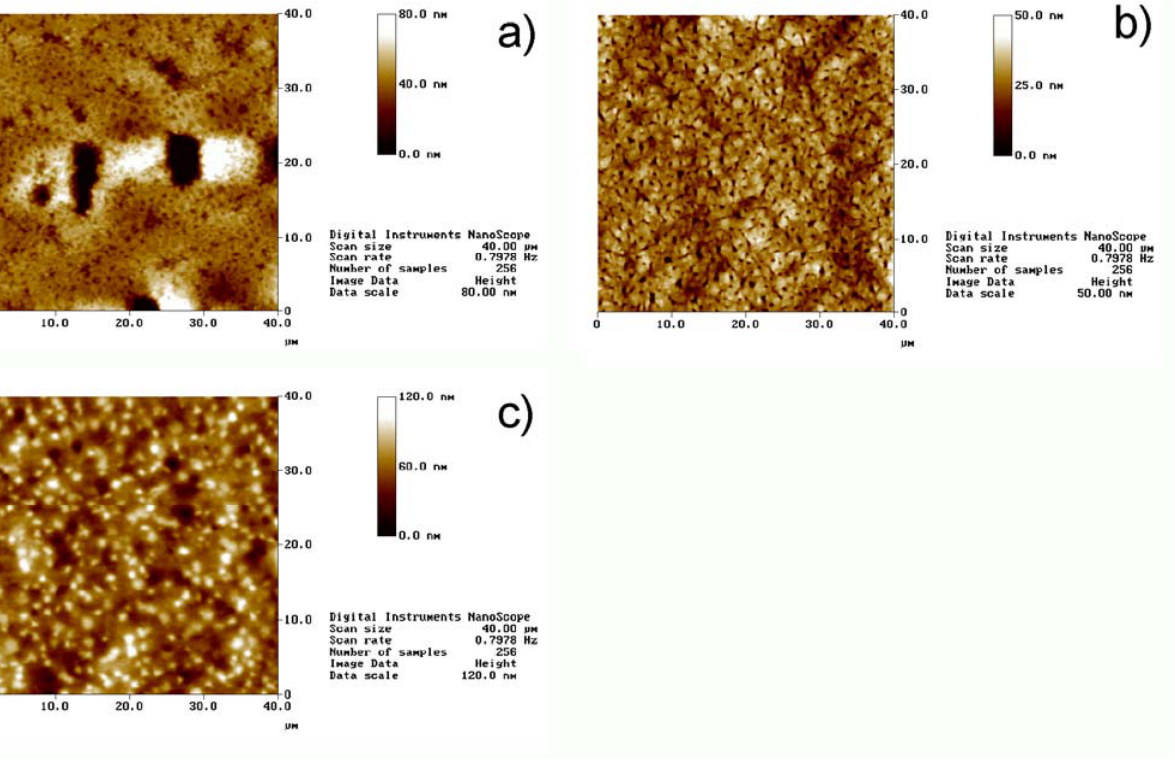
Figure 2. AFM images of different films. a) Film 5, b) film 6, and c) film 7. Note that